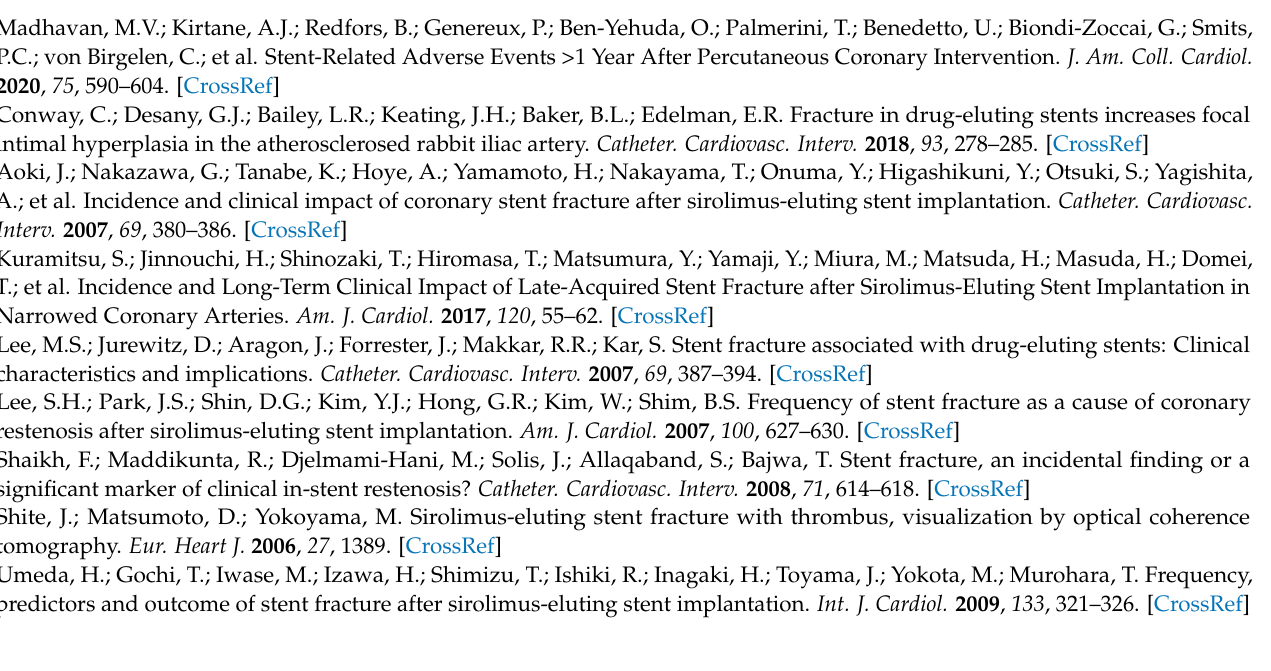
type, Figure S3: Asymmetry and eccentricity in scaffolds, Figure S4: Prevalence of fractures in device failure, Table S1: Parameters of device asymmetry and eccentricity. Both eccentricity and asymmetry tended to be consistently larger in devices with fractures, independently of the device type. BVS, Table S2a: Univariate associations of SF with metallic stents, Table S2b: Univariate associations of SF – bioresorbable scaffolds, Table S3: Device failures, Table S4a: A Multivariate analysis of the predictors of device failure–metallic stents, Table S4b: Multivariate analysis of the predictors of device failure–bioresorbable